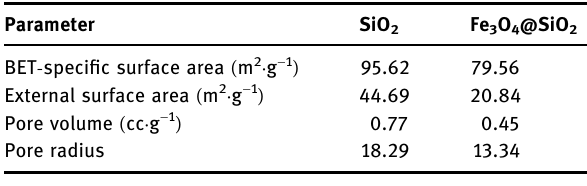
Table 4: Surface parameters of Fe 3 O 4 @SiO 2 in comparison